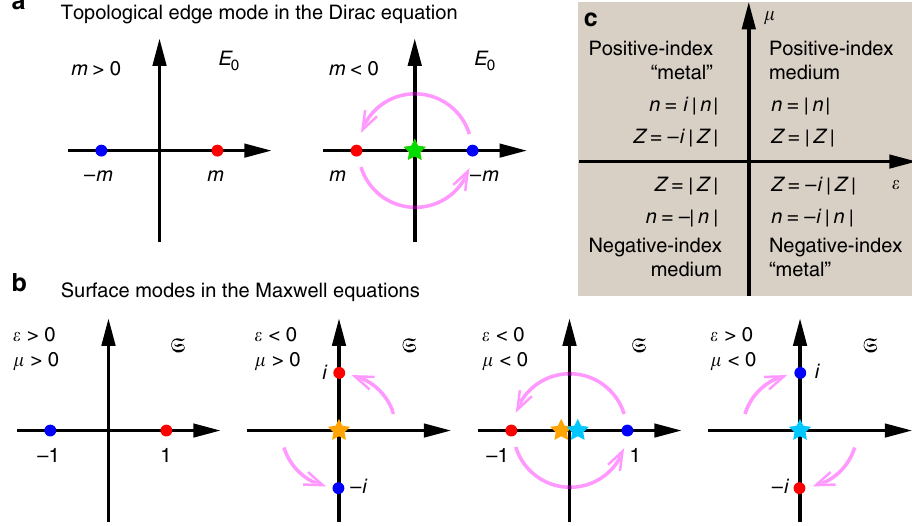
Fig. 2 Winding of the energy and helicity spectra in the Dirac and Maxwell equations. a Changing the sign of the mass m in the Dirac equation is equivalent to a π rotation (shown by the arrows) of the rest-energy spectrum E 0 ≡ E ( 0 ) = m in the complex-mass plane, which results in a single zero-mass surface mode (shown by the star symbol) protected by the topological Z 2 winding number 1 – 3,27 . The dot and star symbols with their colors correspond to the rest- energy spectra of the bulk and surface modes shown in Fig. 1a. b Changing the signs of the permittivity ε and permeability μ in Maxwell equations produces ± π /2 and π rotations of the helicity spectrum in the complex helicity ( S ) plane Eq. (2). This results in the appearance of one or two zero-helicity (transverse-electric and transverse-magnetic) surface modes 15 – 19,34 – 36 (shown by the star symbols) described by the topological Z 4 number (3). c The medium-index diagram showing the signs of the refractive index n and impedance Z in four possible types of media (see Supplementary Note